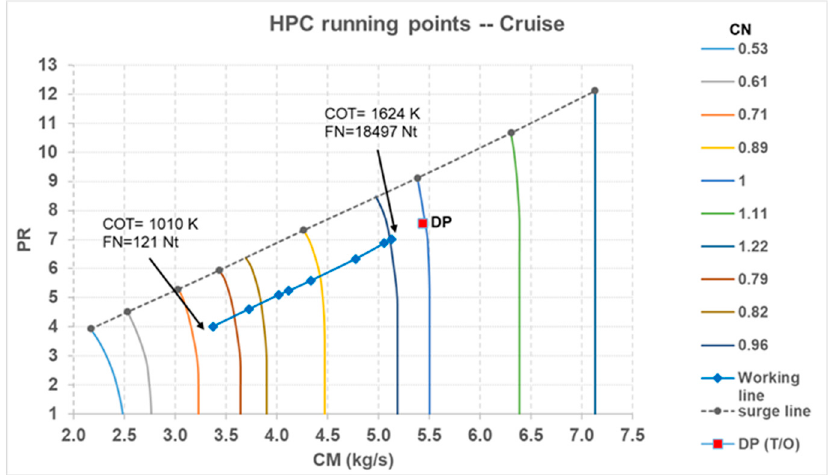
Figure 11. HPC running line at cruise.